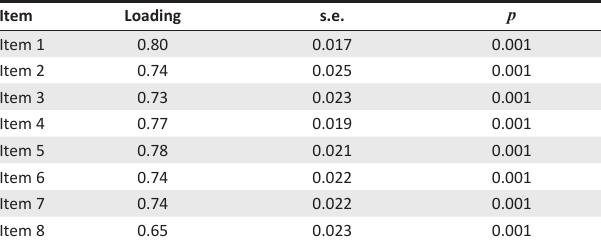
TABLE 1: Standardised factor